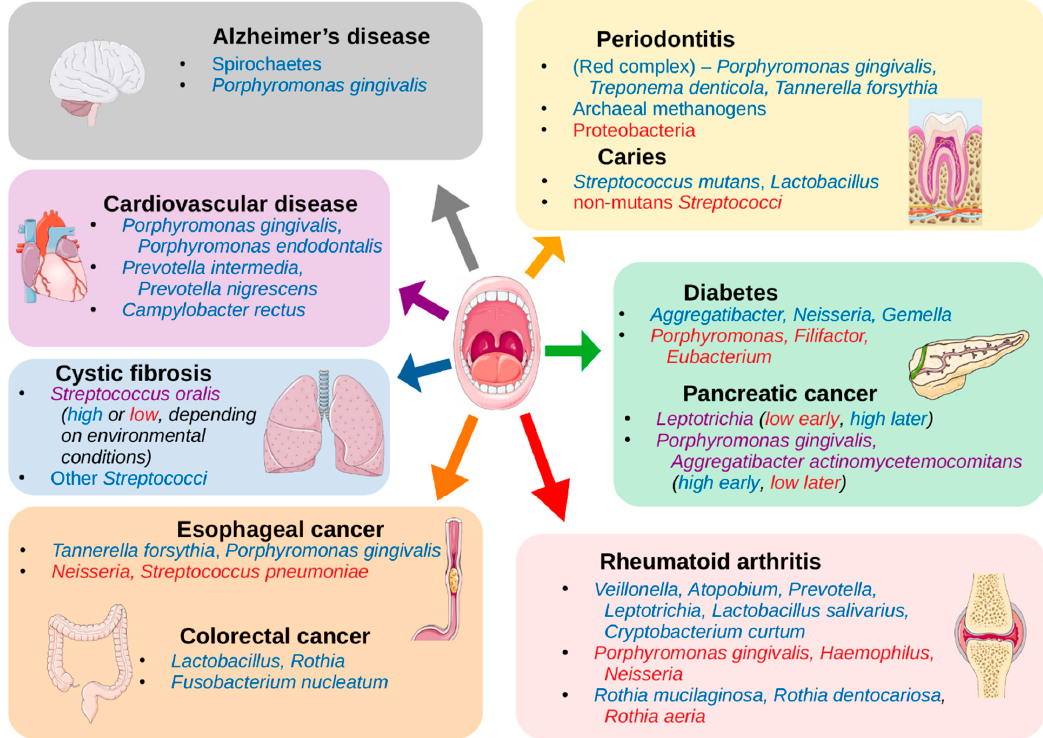
Figure 2. Oral and systemic diseases associated with the oral microbiome. A representation of the associations found between diseases with increases or decreases of the abundances of organisms in the oral cavity (listed in Tables 1 and 2). Organisms listed in blue have been shown to be increased in abundance in the oral cavity in individuals presenting with the noted disease, and organisms listed in red have been shown to be decreased. Those in purple may be either increased or decreased depending on the conditions or progression of the disease. Images of body sites and organs in Figures 1 and 2 were obtained from Servier Medical Art by Servier licensed under CC-BY 3.0. Studies focusing on specific oral niches typically aim to explore a disease relevant to that site. For instance, primary Sjögren’s syndrome (pSS) in the buccal mucosa was believed to be a potential reservoir for pathogens implicit in the disease, wherein the disease samples were shown to have higher Firmicutes/Proteobacteria ratios as compared to healthy controls, and higher abundances of 19 genera [98]. Various efforts have characterized the changes in subgingival and supragingival